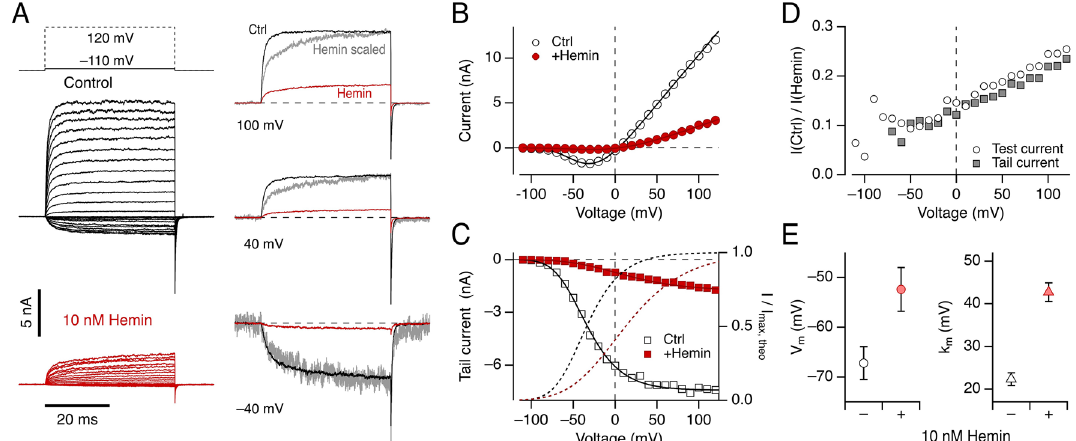
Figure 2. Voltage dependence of hemin-induced Kv10.1 inhibition. ( A , left) Superposition of current traces recorded from inside-out patches according to the indicated pulse protocol in which depolarizations ranged from − 110 to 120 mV in 10-mV increments and 5-s interval before (black) and after (red) application of 10 nM hemin. Holding voltage: − 80 mV. ( A , right) Current traces from the experiment shown on the left for the indicated voltages before (black) and after (red) hemin application. The gray traces are scaled hemin traces to match the maximal control current. Scale factors applied: 100 mV: 3.92; 40 mV: 5.2; − 40 mV: 10.7. ( B ) Mean current measured at the end of test depolarizations as a function of voltage with superimposed data fits according to Eq. (1). ( C ) Tail currents at − 140 mV as a function of test voltage with superimposed Boltzmann fits (Eq. 2). The dashed lines indicate the current normalized to the maximal current obtained in the fits (right axis). ( D ) Voltage dependence of relative current remaining after application of 10 nM hemin determined from test currents (B) (circles) and tail currents (C) (squares). ( E ) Parameters describing the voltage dependence of channel activation according to Eq. (1) without (−) and with 10 nM hemin (+); data are mean ± sem ( n = 6). Solution: Standard